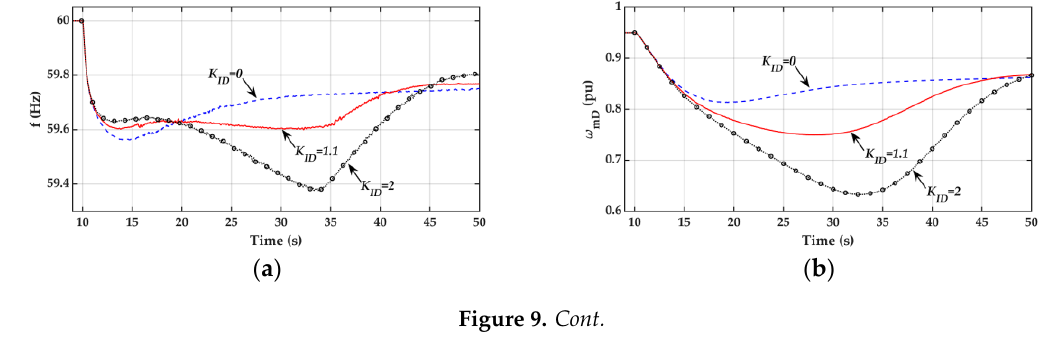
Figure 8. Schematic diagram of particle positions and velocities in every iteration.